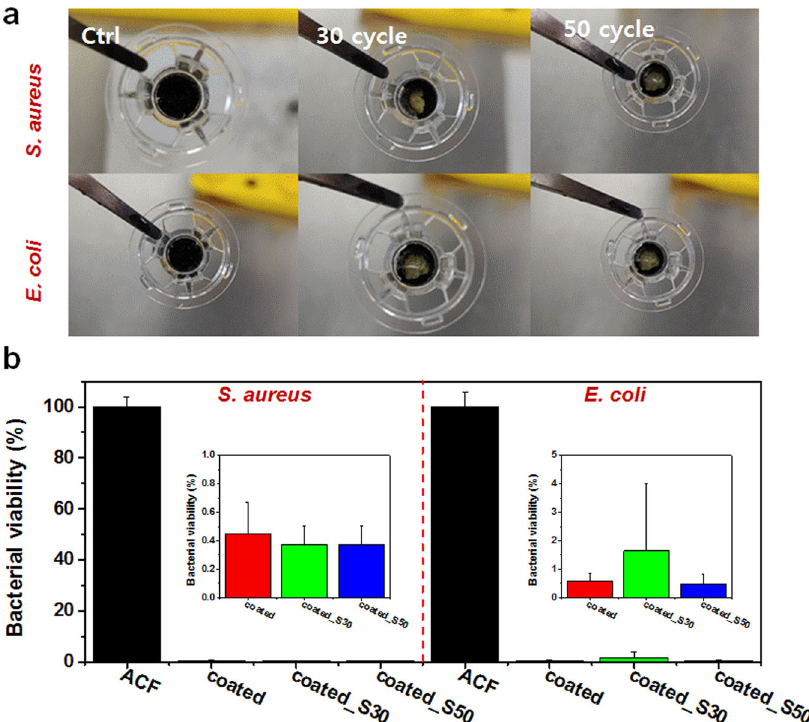
Fig. 7 Bacteria blocking performance of F-PU in-and-out coated ACF. a Photograph images of the bare ACF and the F-PU in-and-out-coated ACF with 30 and 50 scratch cycles after the bacterial penetration tests. b Bacterial viability of Staphylococcus aureus (S. aureus) and Escherichia coli (E. coli) for the bare ACF, the F-PU in-and-out coated ACF, and the coated ACF after 30 and 50 scratch cycles (coated_S30 and S50, respectively). The error bars represent the standard deviations of the